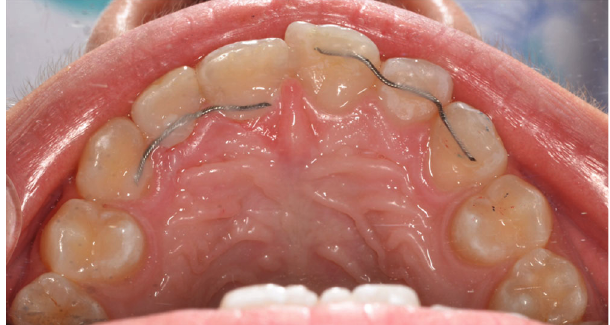
Figure 2: Passive splinting of maxillary lateral incisors to their adjacent teeth. Two separate palatally bonded wires were